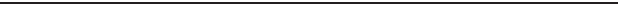
Table 2. Classification of examined cytokines and